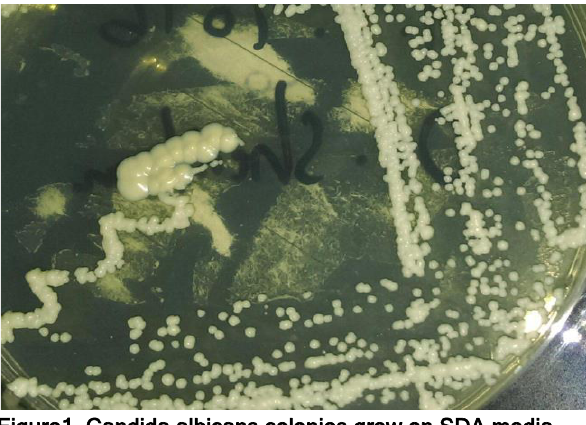
Figure1. Candida albicans colonies grew on SDA media .